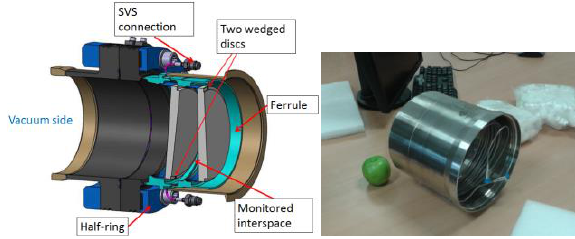
Fig. 7. The ECE primary window design (left) and a typical window assembly prototype (right) .